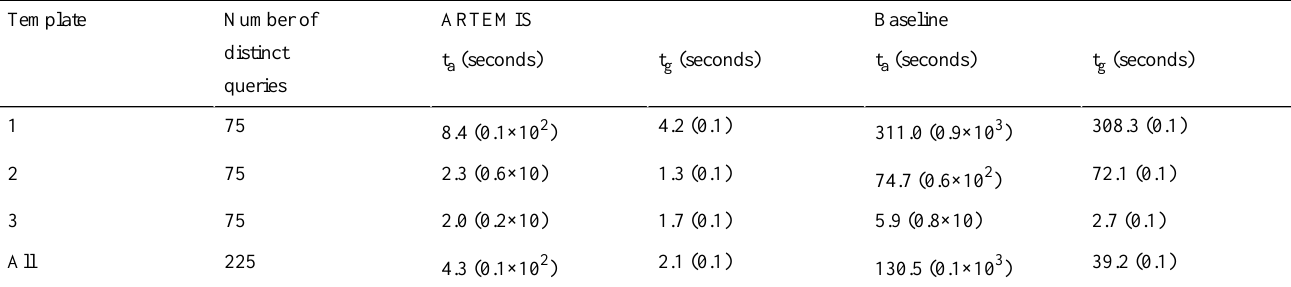
Table 2. Arithmetic (t a ) and geometric (t g ) mean (SD) execution times for the two query mediation strategies: local (Antimicrobial Resistance Trend Monitoring System [ARTEMIS]) versus central (baseline) reasoning.